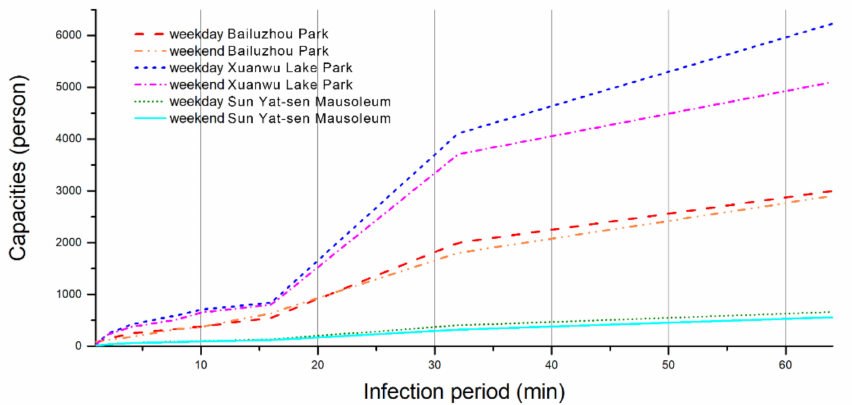
Figure 8. Capacities of different critical periods. The capacity usually grows as the critical infection periods arise. The results of weekday and weekends are similar. The capacity of bigger parks is usually higher, as shown in the difference between Xuanwu Lake Park and Bailuzhou Park. If the park traffic system is flawed as at Sun Yat-sen Mausoleum, its capacity will be very limited. Copyright 2020 © Author, all rights reserved, used by